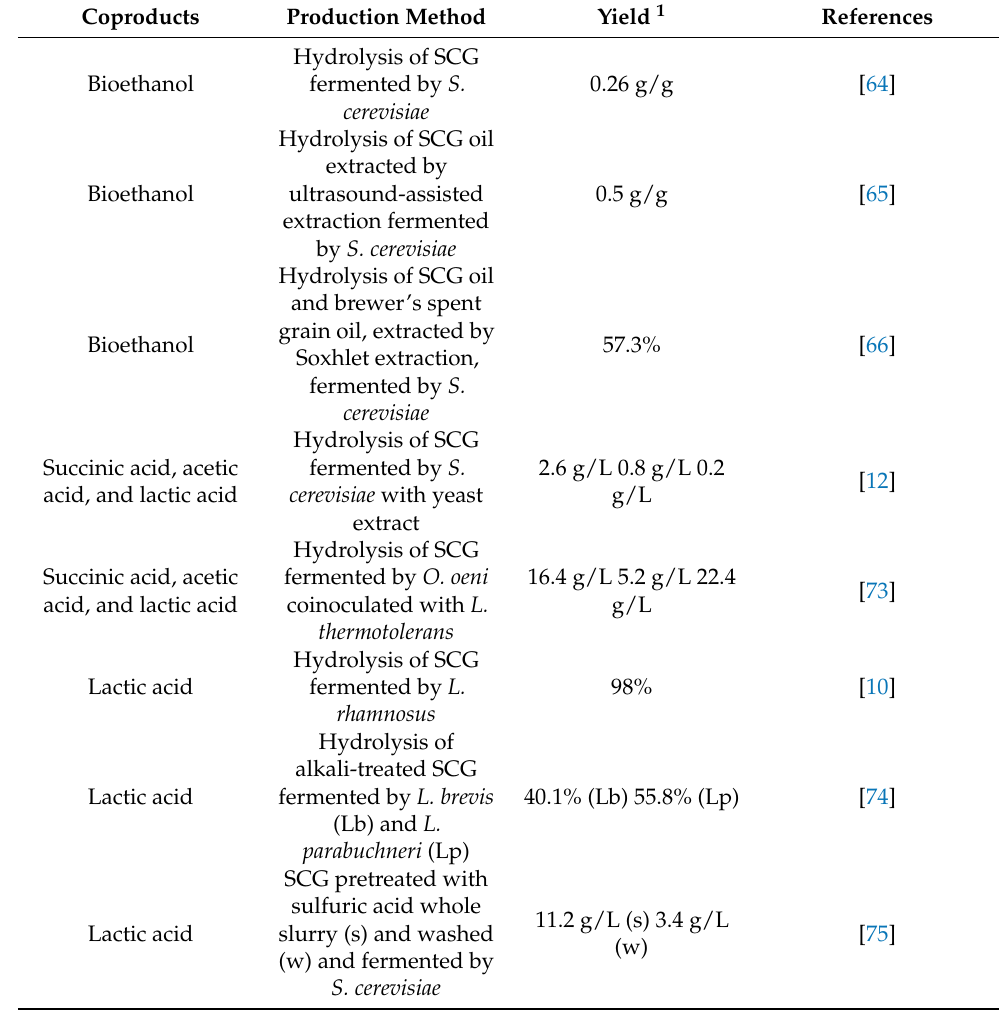
Table 2. Examples of coproducts from SCG